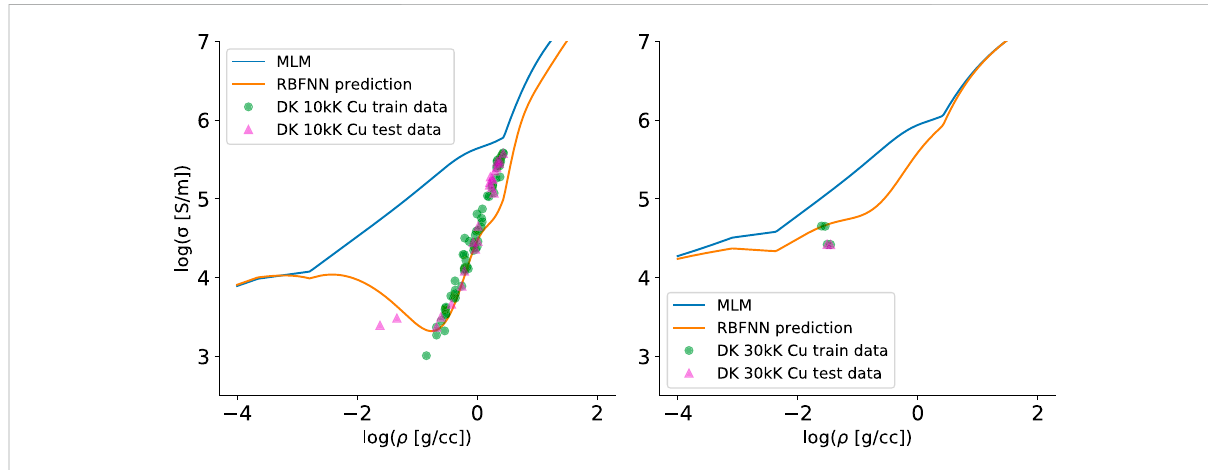
FIGURE 11 DKtrainingdatafor Cuareshownas greendots, withthebaseMLMmodelshown asthetop,bluecurve.TheRBFNNmodelisshowninorange, whichpredictsthedatawellandasymptotically(awayfromthedata)tendstothetrend T ,whichistheMLMmodel.Here, fi vecenterswereused,and the covariance scale hyperparameter was learned from the data in the panel on the left; thus, the prediction in the right panel serves as a test. The magenta triangles indicate the test data (random 20% of the total data).